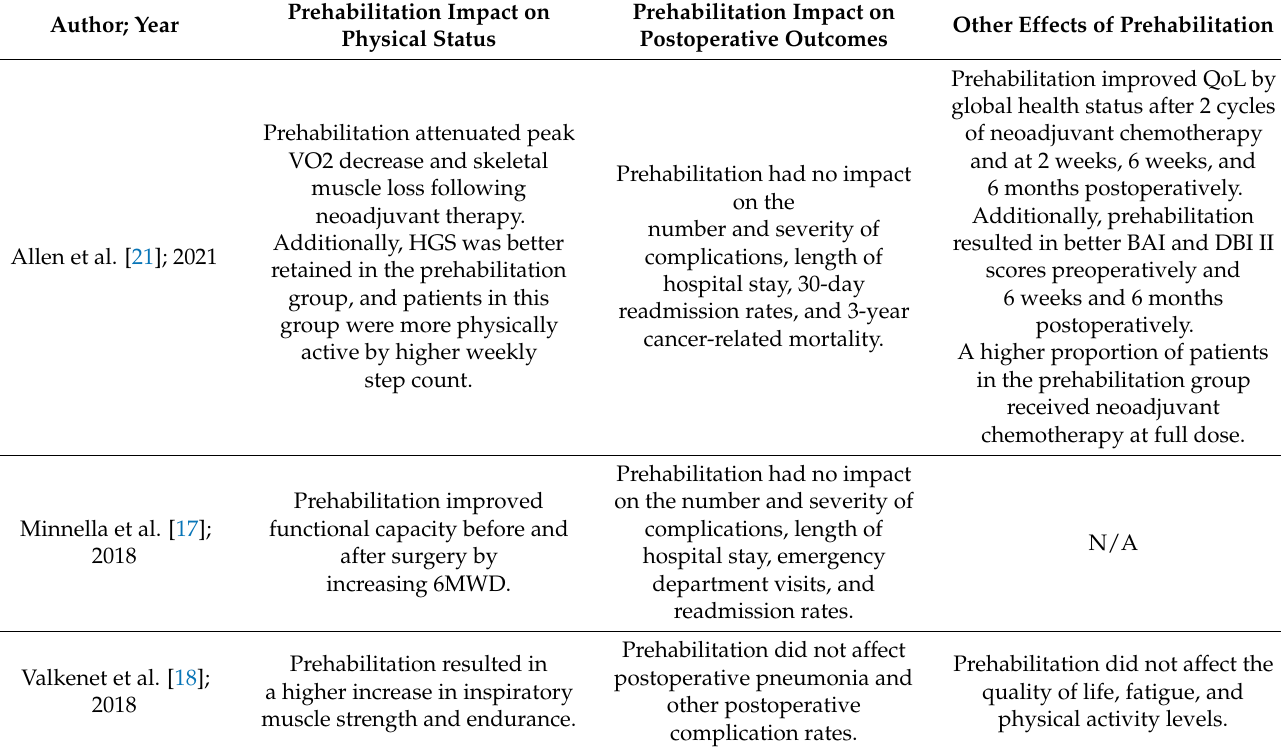
Table 3. Outcomes of included studies evaluating prehabilitation for esophagogastric cancer